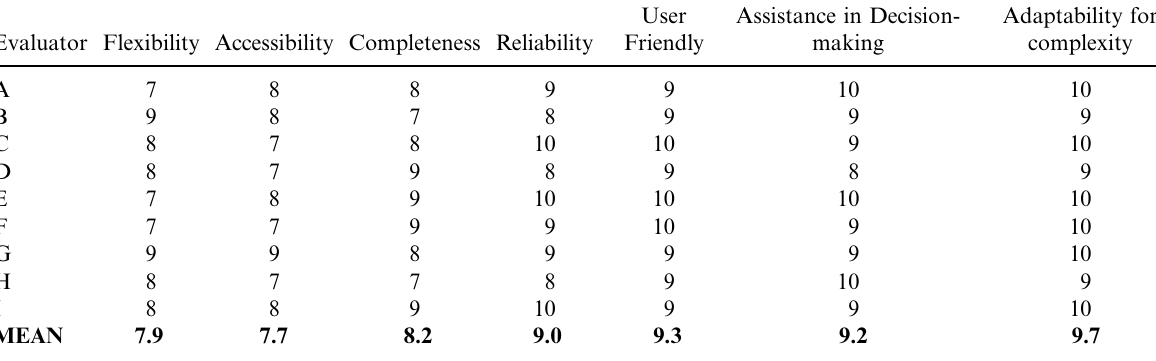
Table 12. Validation results of FSM Evaluator Flexibility Accessibility Completeness